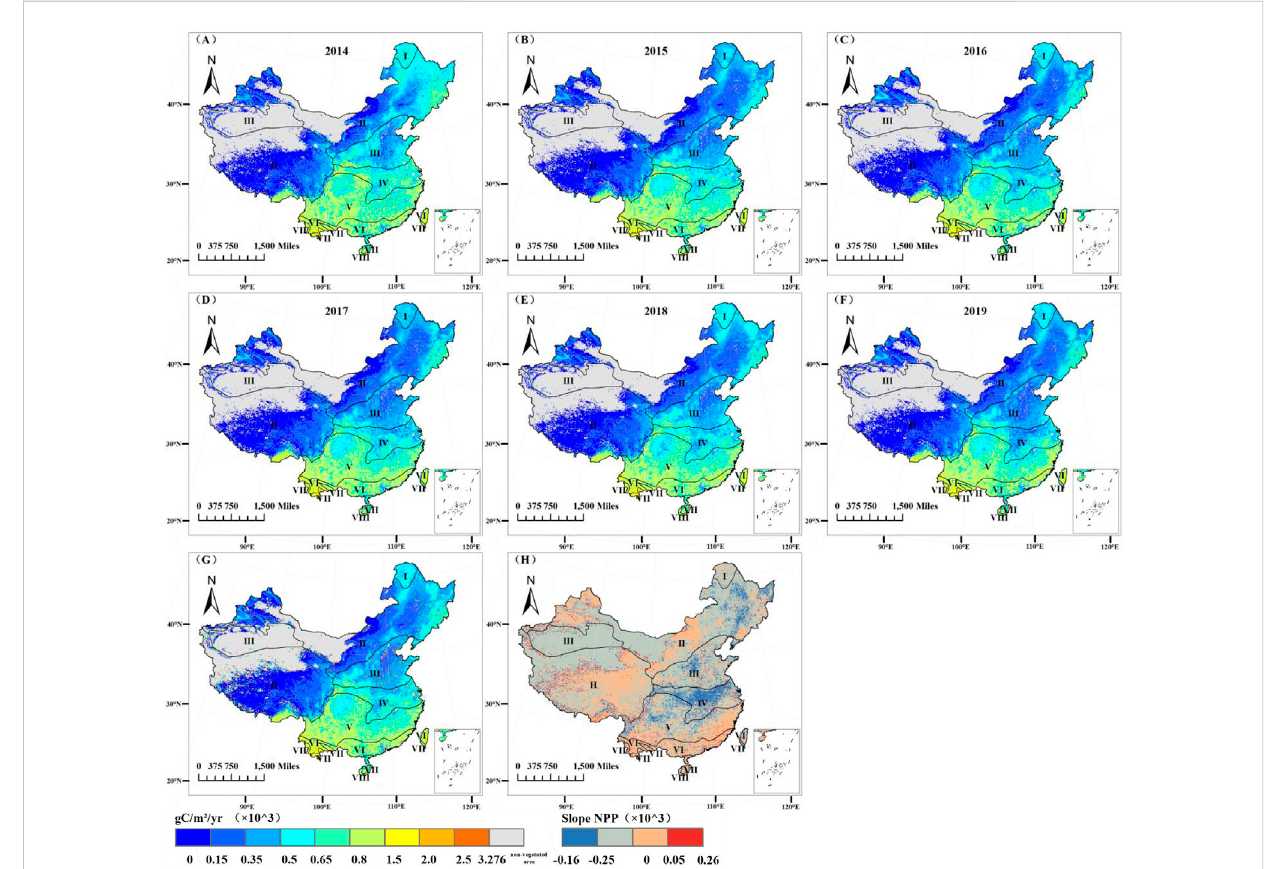
Spatial distribution of annual average NPP (A – G) and annual change rate of NPP (H) in China from 2014 to